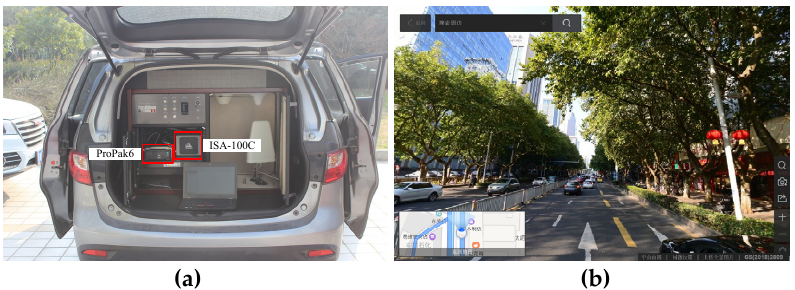
Figure 2. The experimental platform and test environment. ( a ) shows the data acquisition and calibration equipment, ( b ) shows a typical lane scenario in downtown Nanjing (from Baidu Map’s panorama).